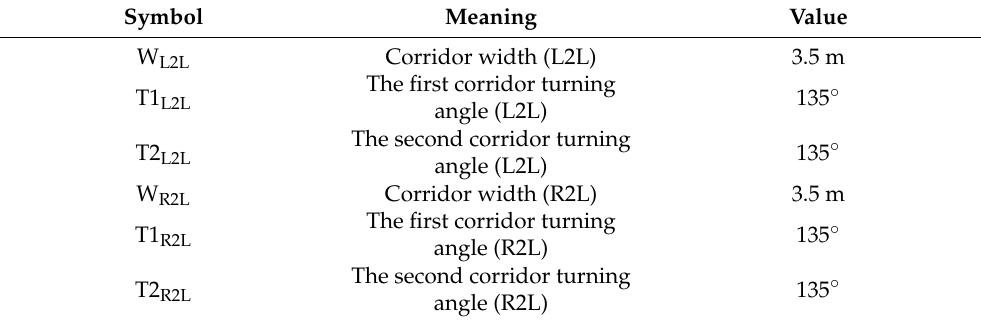
Table A1. Narrow corridor parameters.